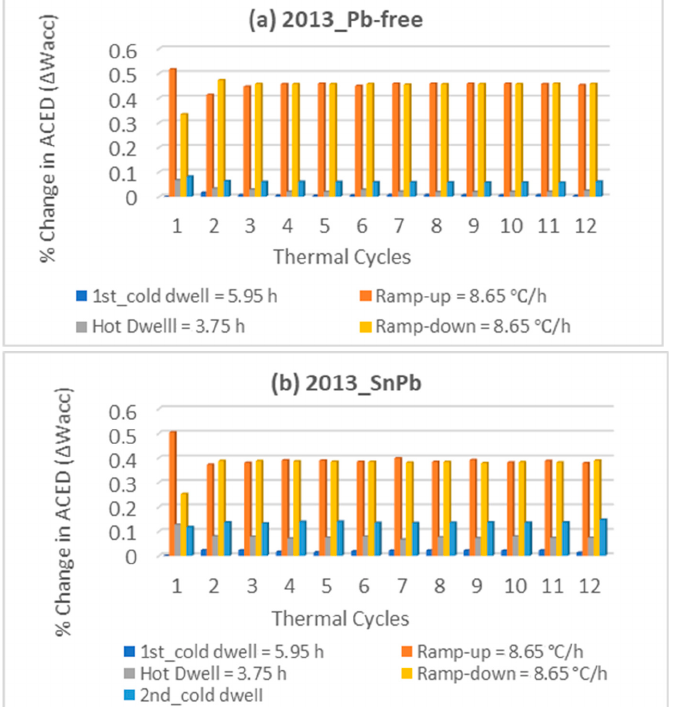
Figure 7. Change in ACED distribution from 2013 thermal cycle for: ( a ) Pb-free ( b ) PbSn intercon- 8a